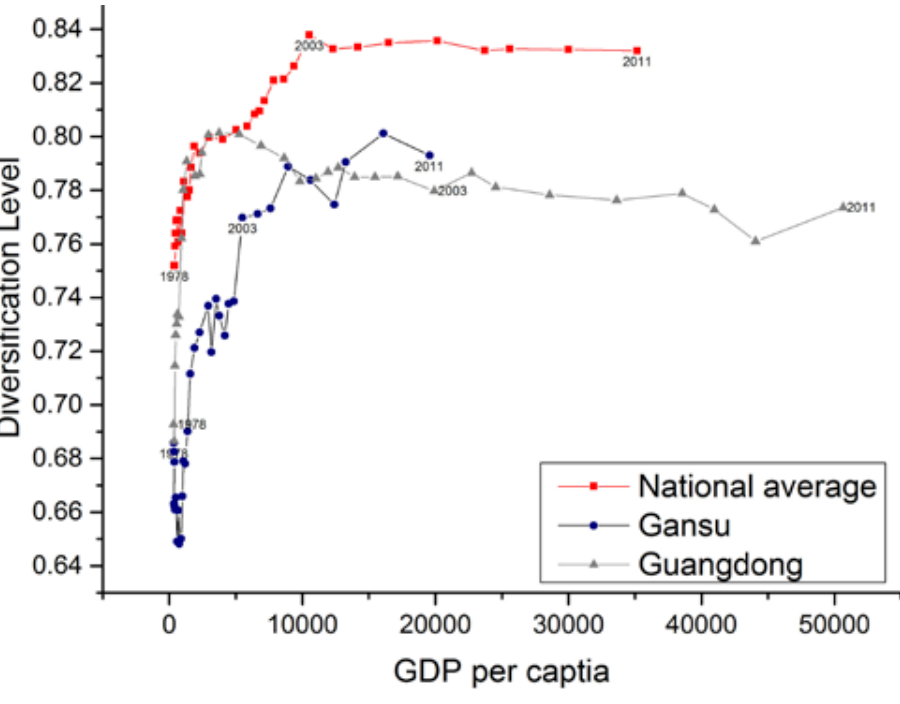
Figure 5. Patterns of agricultural diversification, Gansu province in comparison with Guangdong and national